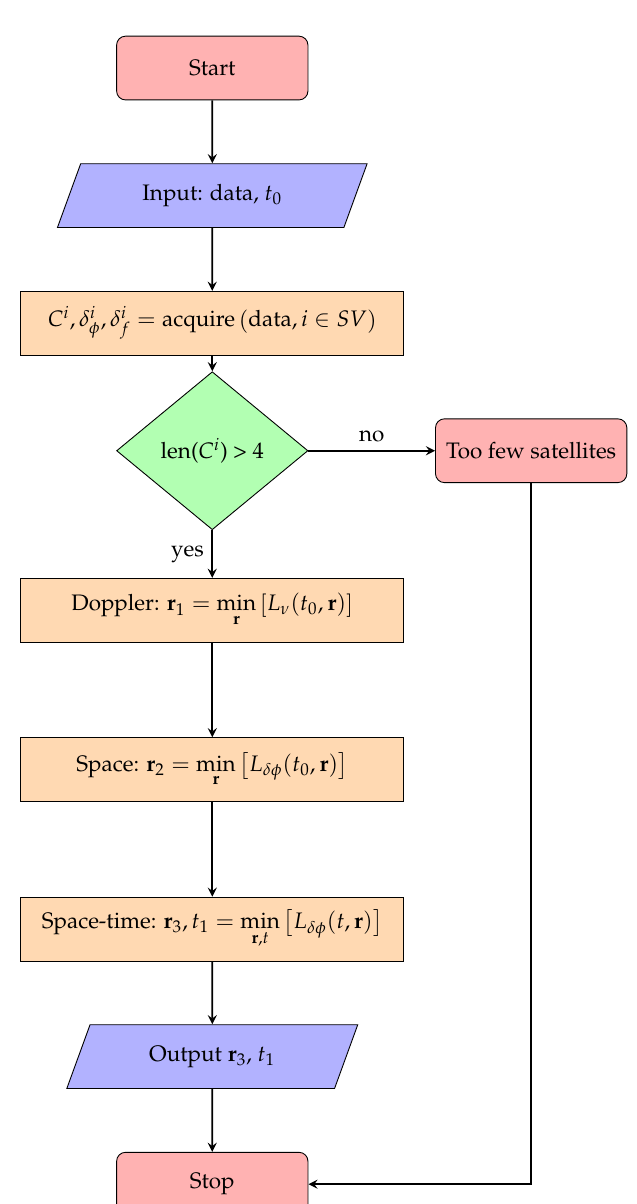
Figure 2. The FastFix positioning algorithm, showing the Doppler-search, space and space-time least-squares optimization